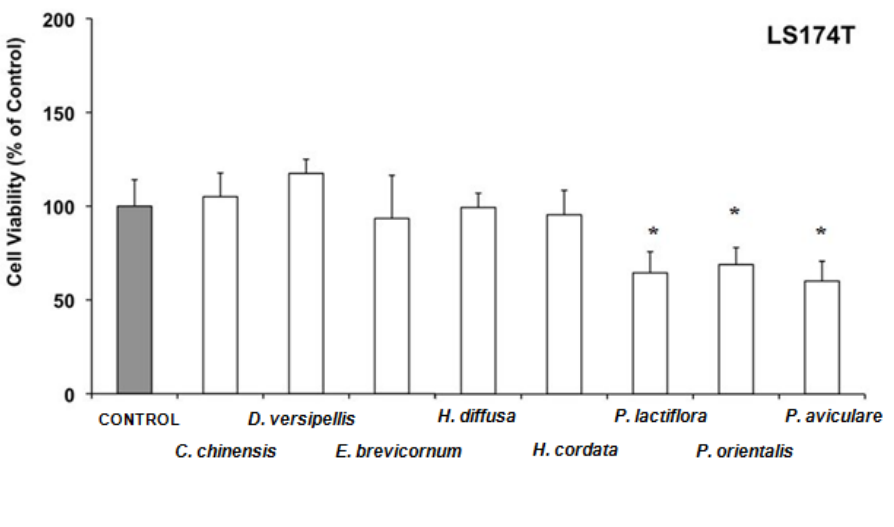
Figure 4. Acute cell toxicity as determined by MTT assay in human colon adenocarcinoma LS 174T cells. Values are means ± SD of four experiments carried out in triplicate. *, p < 0.05 as compared with Control by the Bonferroni method of multiple range